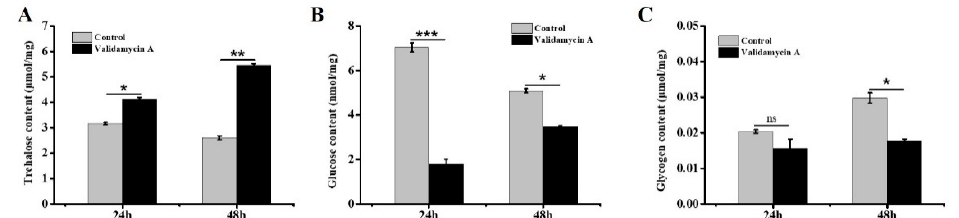
Figure 9. Detection of carbohydrate contents 24 h and 48 h after Validamycin A treatment. ( A ) Trehalose, ( B ) glucose, and ( C ) glycogen. Data are shown as the mean ± SE of three biological replicates. Differences between Validamycin A and control group within each time point were compared using non-parametric Mann–Whitney test. Asterisks above the bars indicated significant differences (* p < 0.05; ** p < 0.01; *** p < 0.001; ns, no significance difference).